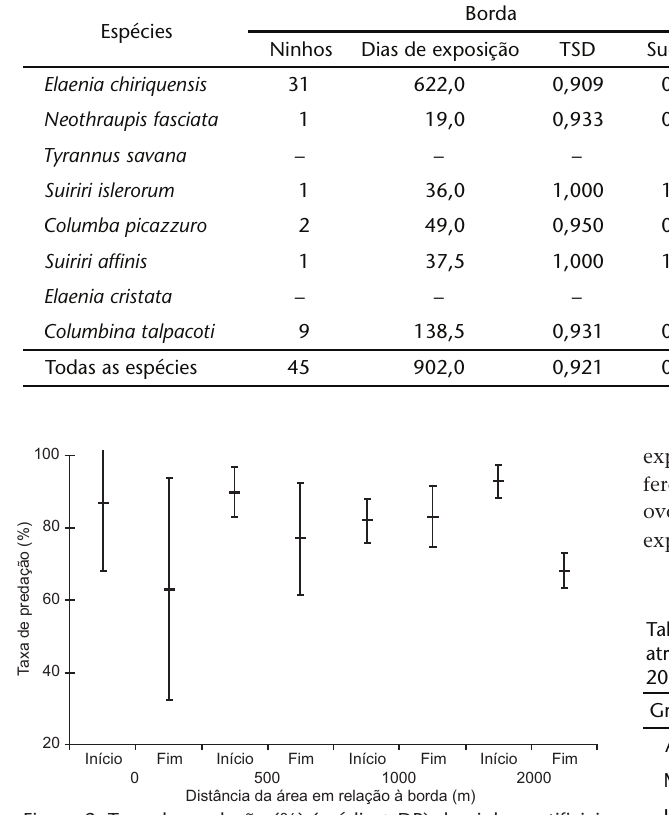
Figura 2. Taxa de predação (%) (média ± DP) de ninhos artificiais em relação à distância da área à borda (m) durante o início e o final da estação reprodutiva de 2004 na Estação Ecológica de Águas